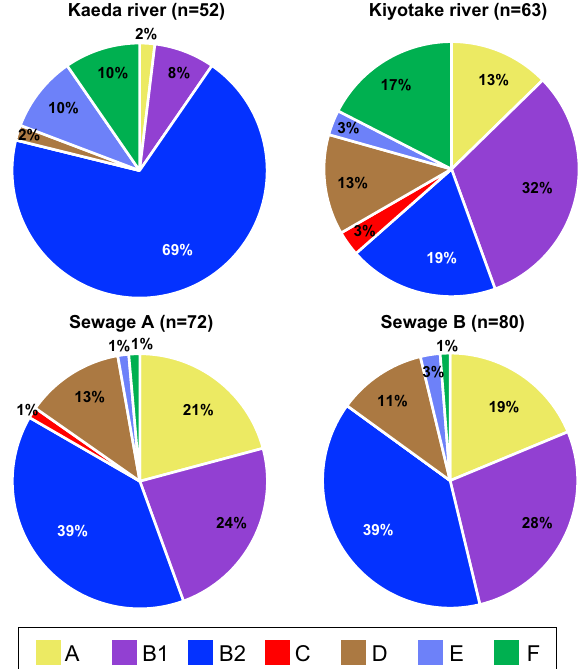
Figure 4. Proportions of phylogroups and clades of E. coli strains isolated from the water